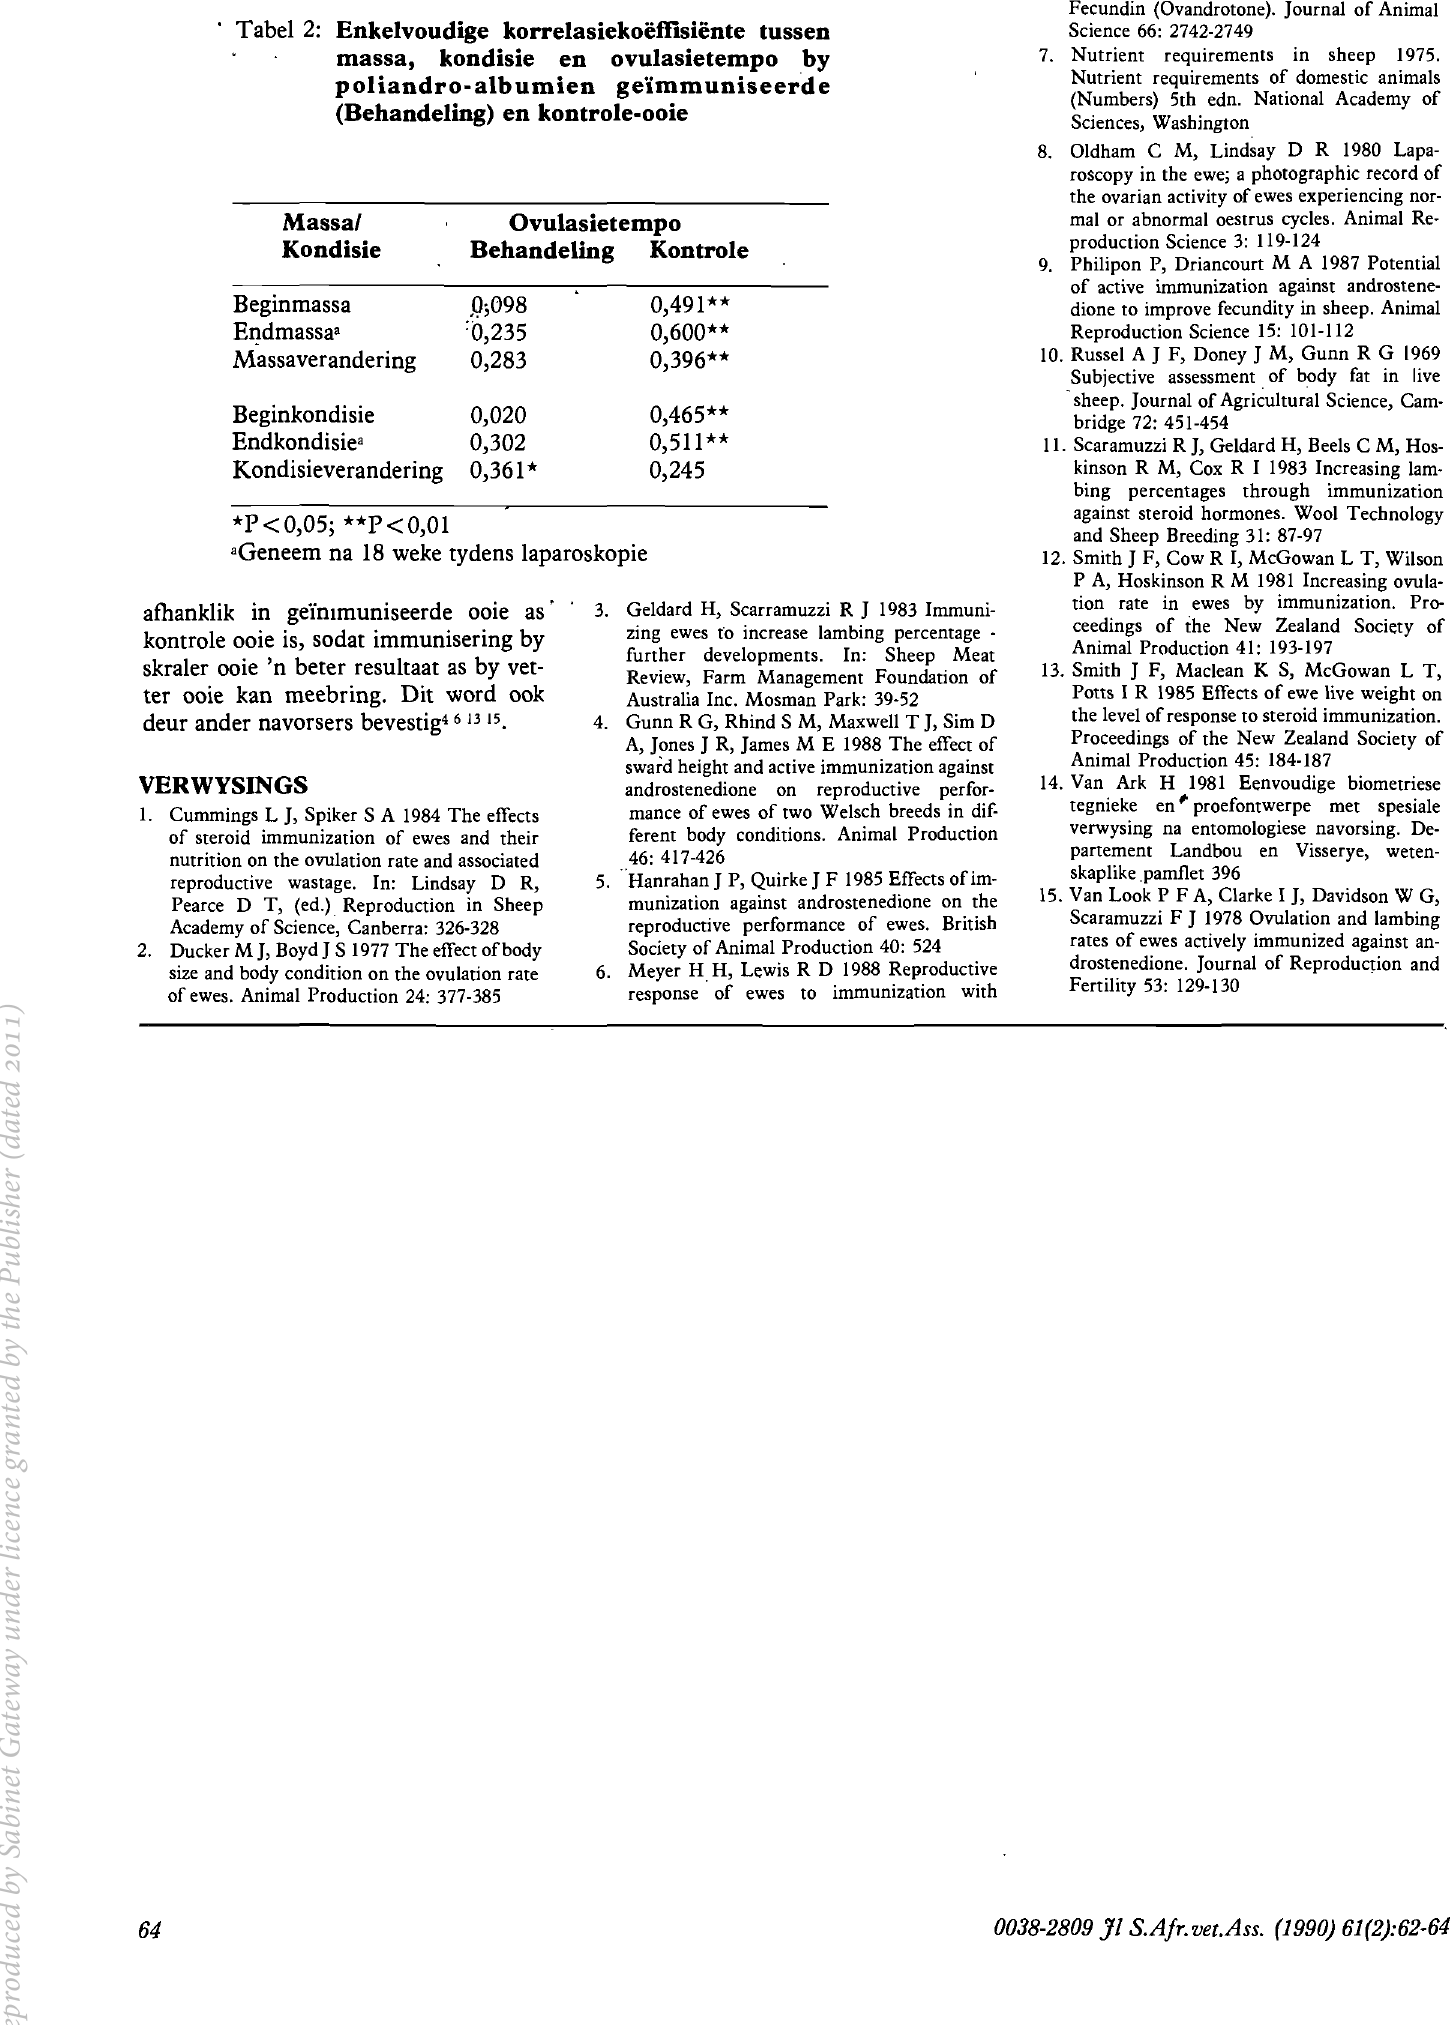
Tabel 2: Enkelvoudige korrelasiekoeffisiente